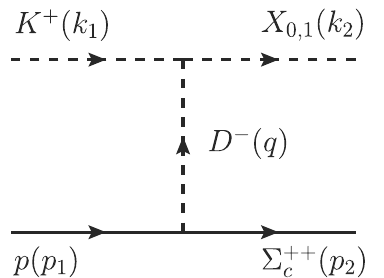
Fig. 1 The diagram responsible for the production of X 0 and X 1 in K + p collisions, where the definitions of the kinematics are also